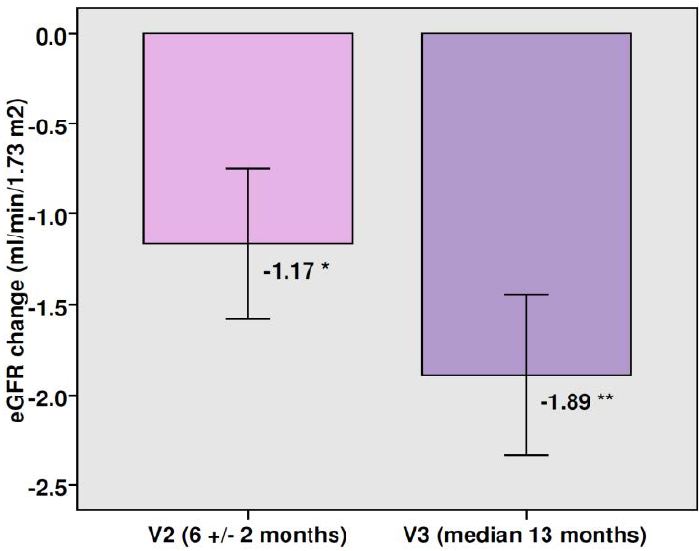
Figure 1. Changes in eGFR after therapy with canagliflozin. Bars: mean change ± SEM. * p = 0.005 vs. baseline, ** p < 0.0001 vs. baseline.